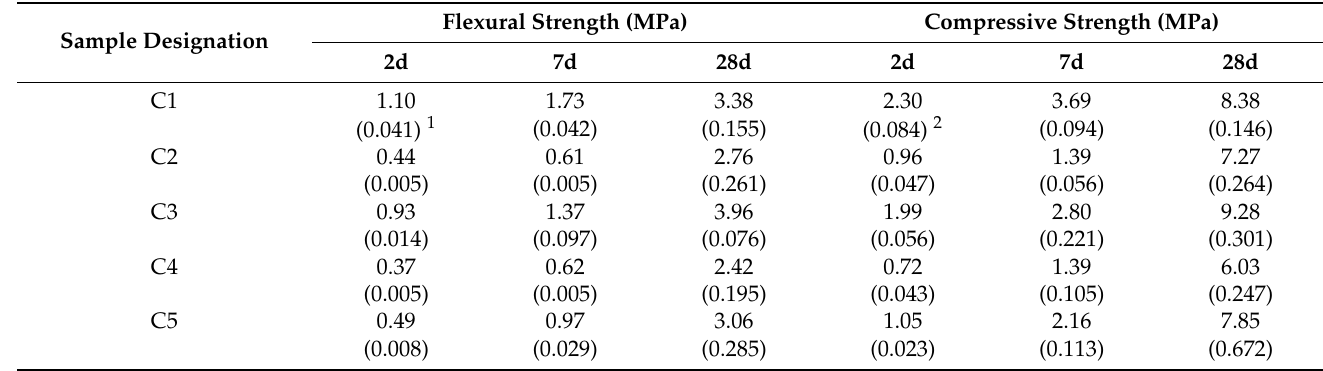
Table 7. Average strength of the mortars.